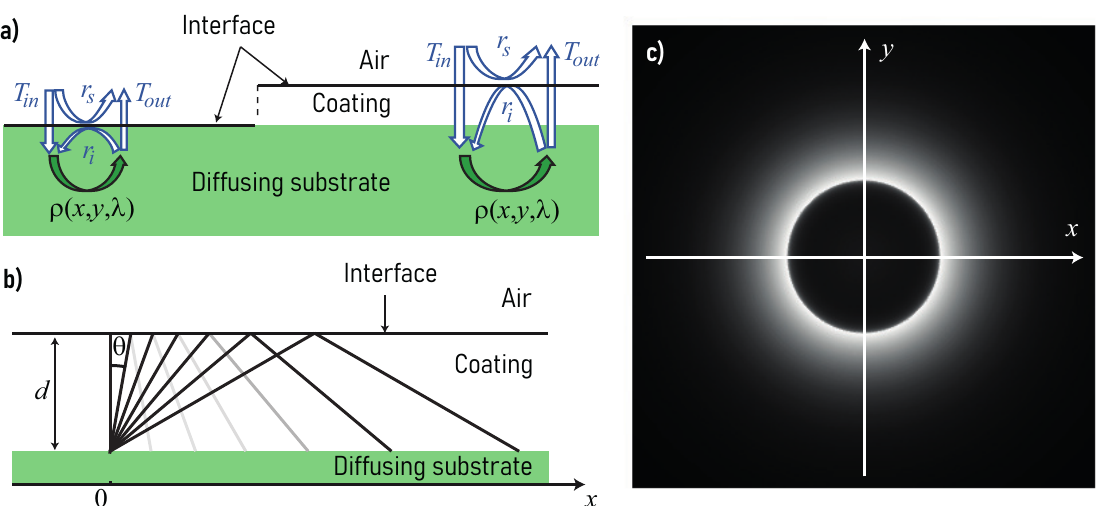
Figure 1. ( a ) Light interactions at the interface between air and a diffusing substrate without and with transparent coating (coating and substrate have the same optical index); ( b ) internal reflections of rays emitted by one point on the substrate at the air–coating interface; the gray levels of the reflected rays depict the Fresnel angular reflectance for a refractive index of coating of 1.5 (light gray means low reflectance, black means total reflectance); ( c ) irradiance map due to the rays internally reflected at the air–coating interface, at the origin of the ring-like halo displayed in Figure 2, when the coating is non-absorbing. This map is a density plot of function h ( x , y ,1) defined in Equation (6).